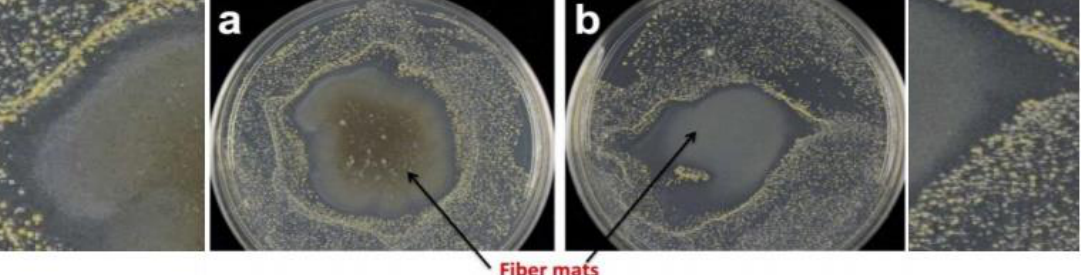
Figure 18. Antibacterial activity of fibrous mats ( a ) chitosan 0.2% wt with silver nanoparticles and ( b ) chitosan 0.8% wt with cinnamaldehyde when both were exposed to Staphylococcus aureus. The inhibition zone is evident around the mat with both composites. Reproduced with permission from [157]. Copyright 2018 NMJ.